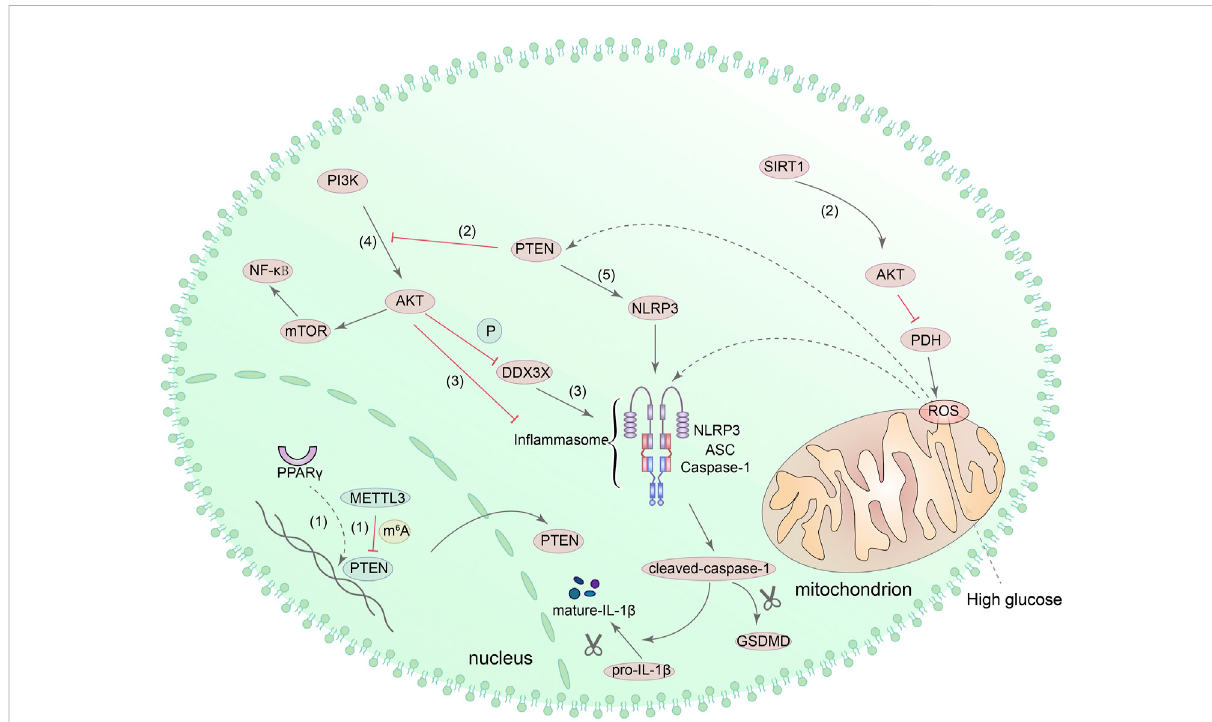
FIGURE 6 PTEN/PI3K/Akt signaling pathway is involved in the regulation of pyroptosis. (1) PPAR can regulate the transcription of PTEN, and METTL3 can also modify PTEN. (2) Upregulation of PTEN can reduce the phosphorylation of PI3K and Akt. SIRT1 can interact with Akt directly, consequently promotingtheactivityofAktandinhibitingtheproductionofROS via Akt/PDHaxis.(3)DDX3XcanbephosphorylatedbyAkt,andAktcanincreasethe phosphorylation of NLRP3. (4) PI3K/Akt/mTOR/NF- κ B signaling pathway can also regulate pyroptosis mediated by NLRP3 in fl ammasome. (5) PTEN directly interacts with NLRP3 and enables NLRP3 in fl ammasome assembly and